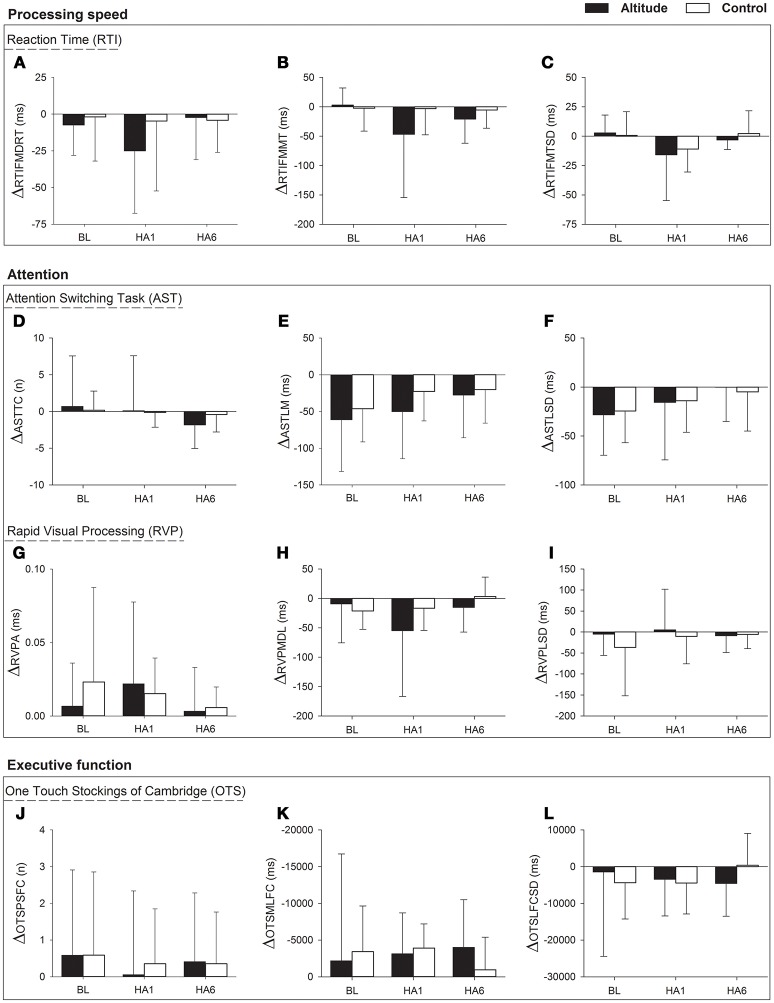
Changes in cognition (CANTAB outcome parameters with RM-ANOVA) over two cycles (ΔCANTAB = Cycle 2 – Cycle 1) at very high altitude during acute, subacute and repeated exposure comparing with controls. Figure has three horizontal box panels. The first panel (A–C) illustrates “processing speed” i.e., changes in Reaction Time (RTI) parameters (ΔRTIFMDRT, ΔRTIFMMT, and ΔRTIFMTSD), the second box panel contains “attention” in which first panel within the box (D–F) shows changes in Attention Switching Task (AST) parameters (ΔASTTC, ΔASTLM, and ΔASTLSD) while the second panel within the second box (G–I) shows changes in Rapid Visual Processing (RVP) parameters (ΔRVPA, ΔRVPMDL, and ΔRVPLSD) and the third box panel (J–L) shows changes in One Touch Stockings of Cambridge (OTS) parameters (ΔOTSPSFC, ΔOTSMLFC, and ΔOTSLFCSD). The x-axis depicts different time points of data collection for Altitude exposure and Control groups at Baseline (BL), Acute exposure (HA1) and Acclimatization exposure (HA6). The y-axis depicts changes in cognitive parameters as mean ± SD for Altitude and Control group. Symbols: Black filled bars, Altitude group; empty bars, Control group; Δ, Change; ms, milliseconds; n, number. BL, baseline; HA1, acute exposure to altitude (day 1); HA6, acclimatization exposure to altitude (day 6); RTI, Reaction Time; AST, Attention Switching Task; RVP, Rapid Visual Processing; OTS, One Touch Stockings of Cambridge; ΔRTIFMDRT, RTI Median Five-choice Reaction Time; ΔRTIFMMT, RTI Mean Five-choice Movement Time; ΔRTIFMTSD, RTI Five-choice Movement Time Standard Deviation; ΔASTTC, AST Total Correct; ΔASTLM, AST Latency Mean; ΔASTLSD, AST Latency Standard Deviation; ΔRVPA, Rapid Visual Processing Accuracy; ΔRVPMDL, ΔRVP Mean Response Latency; ΔRVPLSD, RVP Response Latency Standard Deviation; ΔOTSPSFC, OTS Problems Solved on First Choice; ΔOTSMLFC, OTS Mean Latency First Choice; ΔOTSLFCSD, OTS Latency to First Choice Standard Deviation.